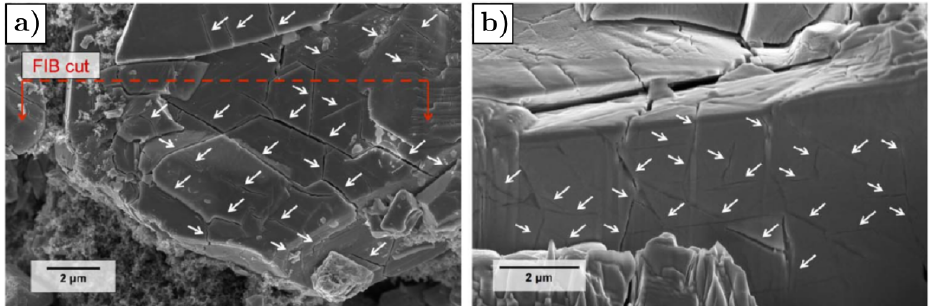
Figure 12. ( a ) Fracture in LMO particle after 16 deep discharge cycles with Jahn–Teller transformation and 51 cycles without Jahn–Teller transformation. ( b ) Internal view of LMO particle shown in ( a ) after FIB milling. White arrows point to the cracks. Reprinted with permission by Journal of The Electrochemical Society from [84], Copyright